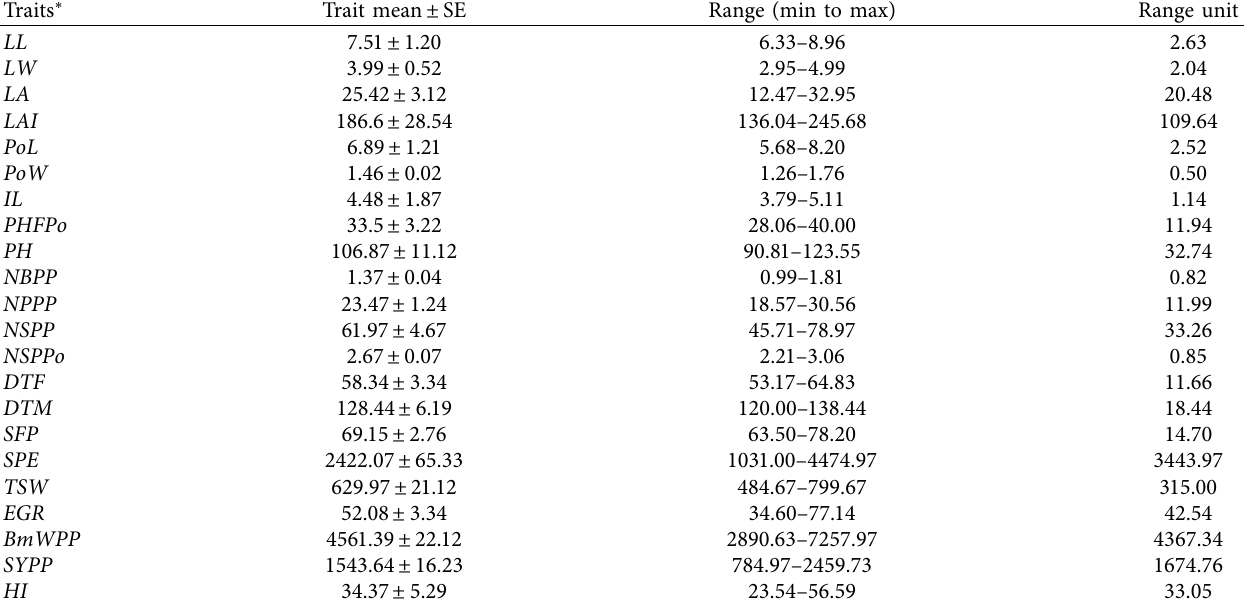
Table 6: Performance of the quantitative traits expressed in mean’s, range and range-unit. Traits